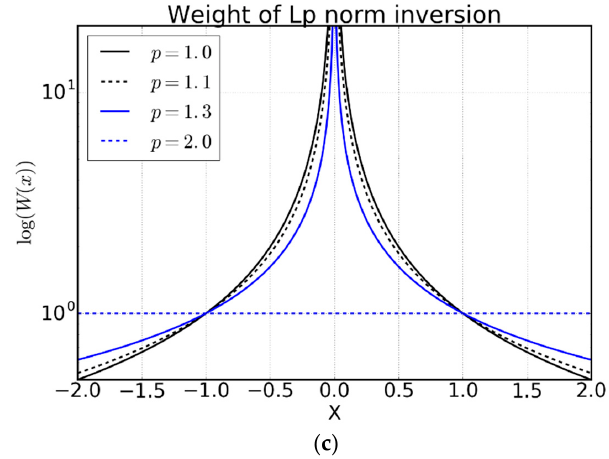
Figure 3. Cost functions ( a ), their first-order derivatives ( b ), and the weights of L p -norm inversion ( c ) for different values of p .